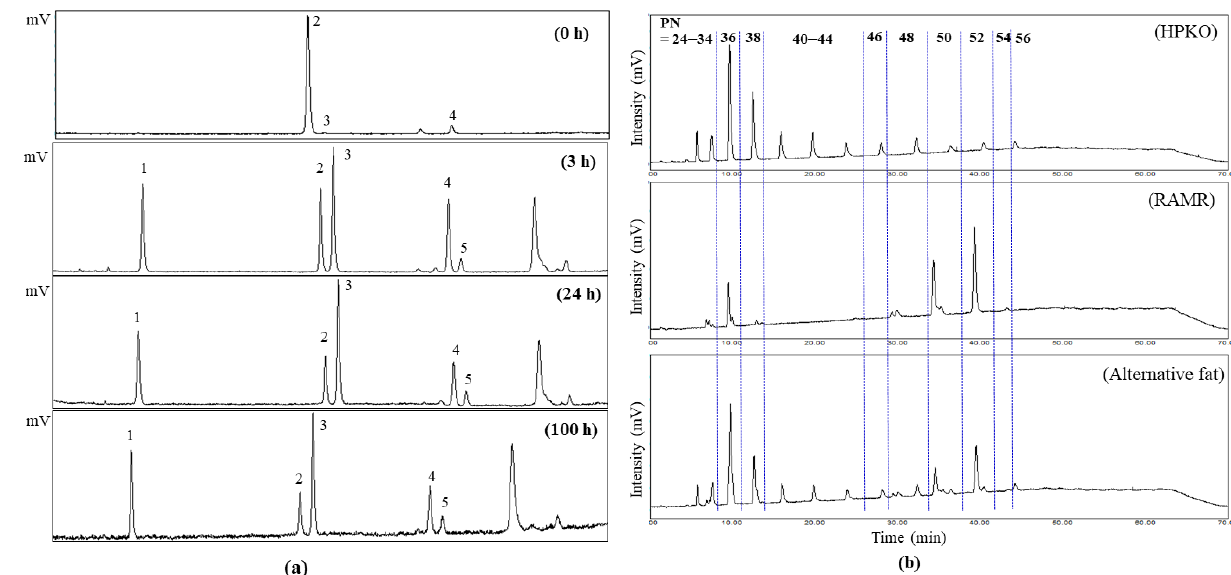
Figure 2. Triacylglycerol (TAG) regioisomer chromatograms of acyl migration reactants (0, 3, 24, and 100 h) obtained via Ag-HPLC analysis ( a ) and TAG molecular species chromatograms of hydrogenated palm kernel oil (HPKO), refined amyl-migration reactant (RAMR), and alternative fat product (RAMR:HPKO = 4:6 blend, w / w ) obtained from analysis of the revered-phase HPLC ( b ). TAG regioisomer chromatograms: 1. SSS (saturated-saturated-saturated); 2. SUS (saturated-unsaturated-saturated); 3. SSU (saturated-saturated-unsaturated); 4. SUU (saturated-unsaturated-unsaturated); 5. USU (unsaturated-saturated-unsaturated).